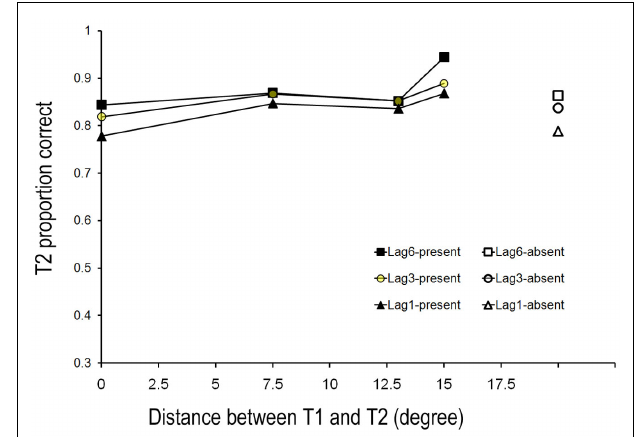
FIGURE 3 | Mean detection accuracy ofT2 when participants correctly reportedT1 for control groups in Experiment 1.